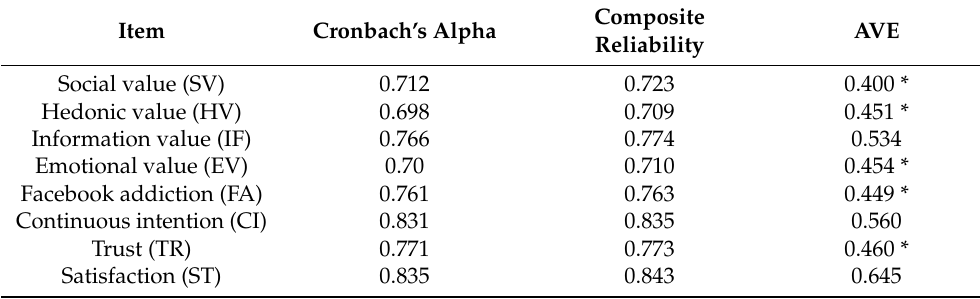
Table 5. Validity and reliability.